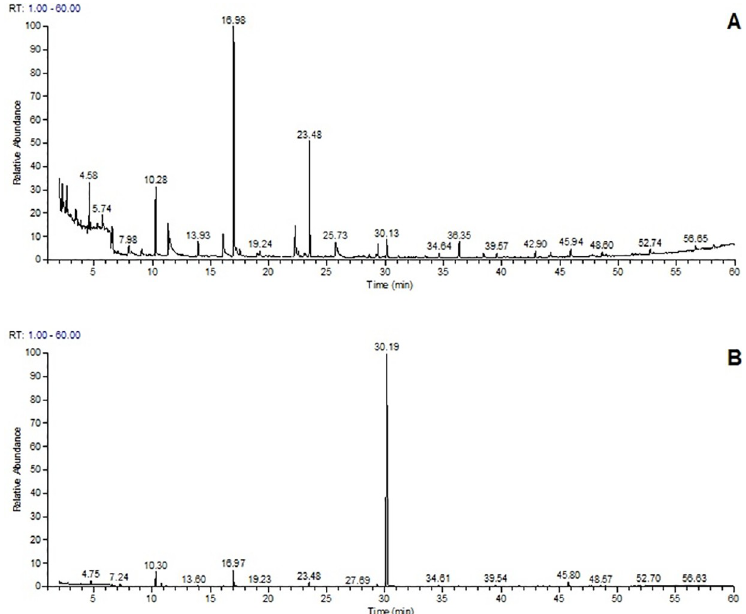
Fig 3. SPME-GC-MS chromatogram of extracellular media (a), and methanolic extract of Flavobacterium sp. biomass (b).